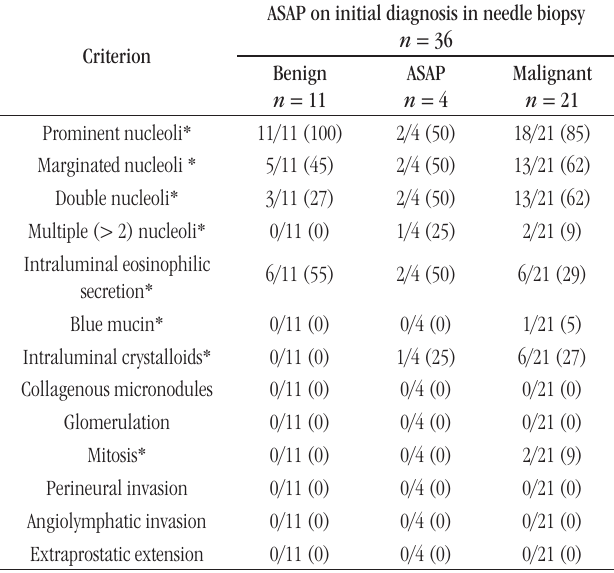
taBLE 3 − Frequency of morphological criteria for the diagnosis of acinar adenocarcinoma in 36 consecutive core needle biopsies with ASAP on initial diagnosis, stratified according to the final diagnosis after immunohistochemical evaluation of basal cell markers